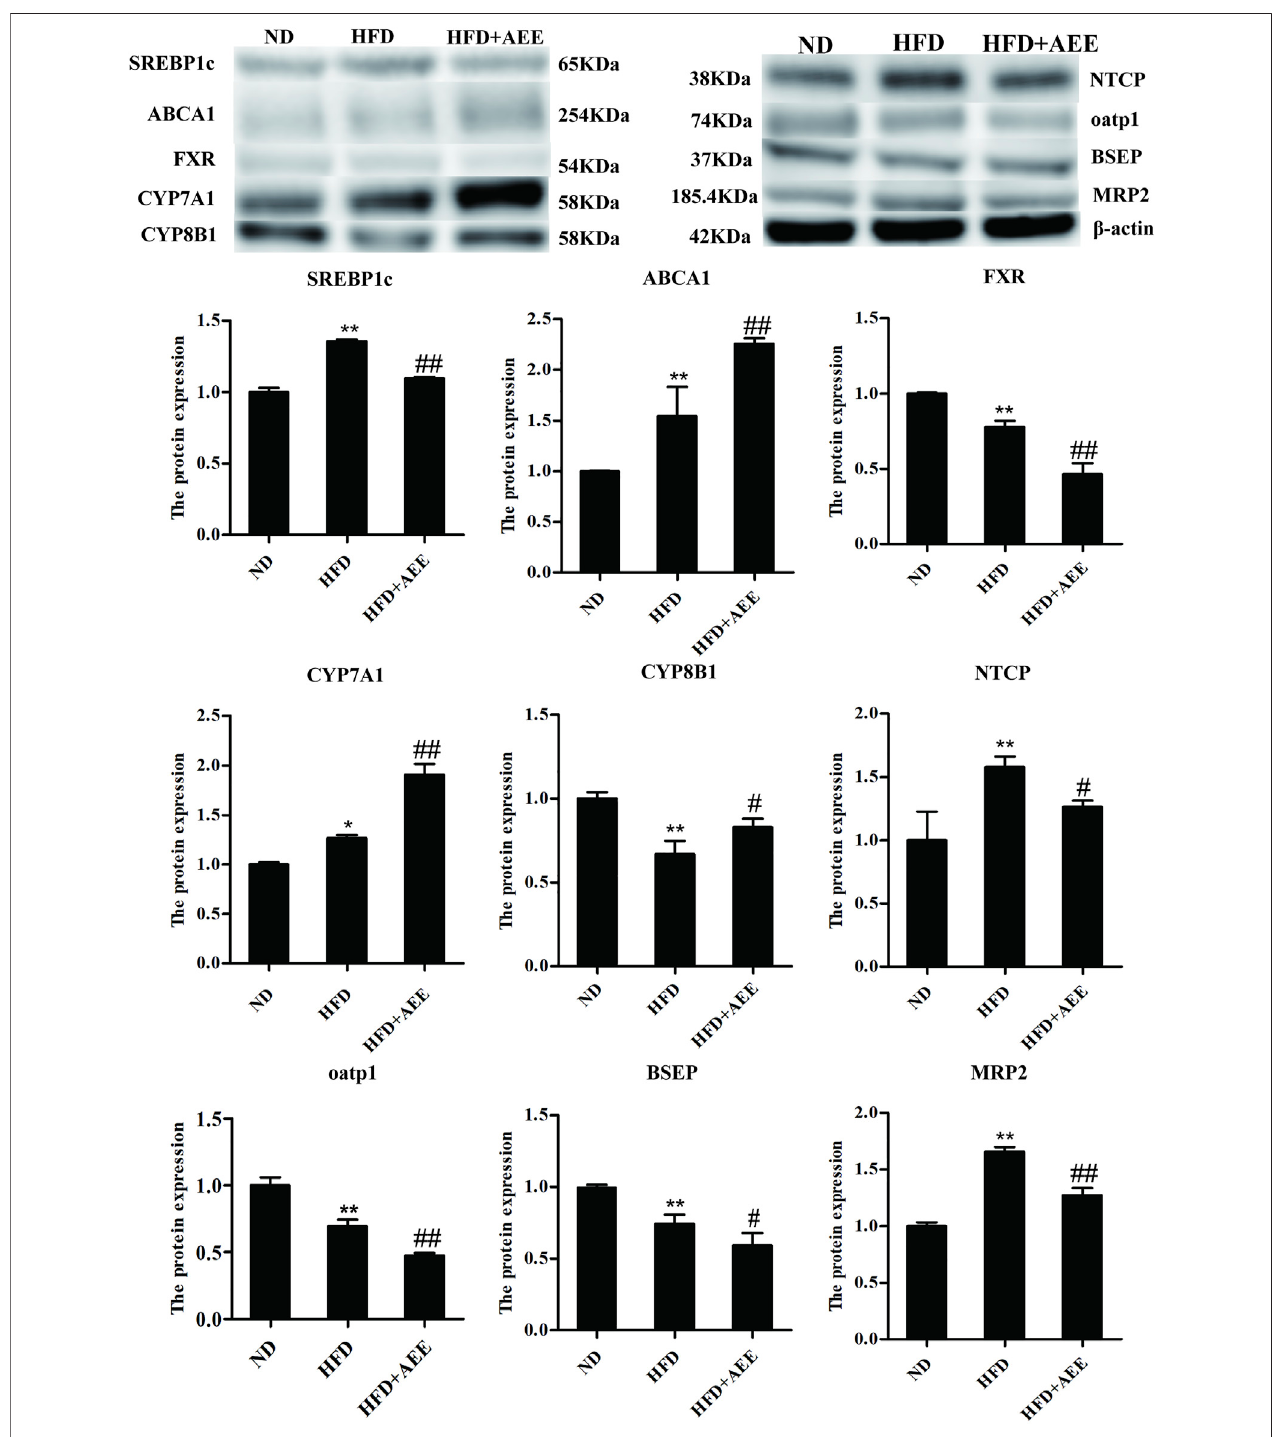
FIGURE6| Effects ofAEEonprotein expressionrelated withcholesteroland BAmetabolisminhyperlipidemiarat.Dataareexpressed asthemeans ± SD( n (cid:1) 10). HFD, high-fat diet; AEE, aspirin eugenol ester. * p < 0.05, ** p < 0.01 compared with the ND group; # p < 0.05, ## p < 0.01 compared with the HFD group.